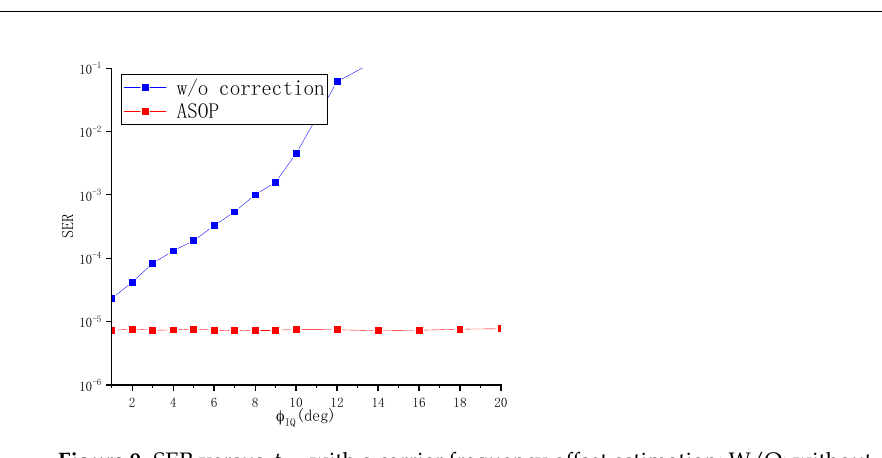
( c )( b ) 5 O 10 O 15 O GSOP w/o correction Ideal GSOP SER OSNR/0.1nm (dB) ( a ) 5 O 10 O 15 O SYOP w/o correction SER OSNR/0.1nm (dB) 5 O 10 O 15 O ASOP w/o correction SER OSNR/0.1nm (dB) Figure 8. Symbol error rate (SER) versus the optical signal-to-noise ratio (OSNR) with different ϕ IQ of 5°, 10°, and 15° for the ( a ) GSOP, ( b ) the SYOP, ( c ) and the ASOP; W/O: without. Figure 9 illustrates the SER performance as a function of ϕ IQ with a frequency offset of 400 MHz. The phase drift in the receiver caused by the frequency offset between the transmitter and the local oscillator could be compensated with the carrier frequency esti- mation algorithm. The carrier frequency estimation was completed by a frequency offset estimation module in VPI with the FFT-based frequency offset estimation algorithm. As we can see, without nonorthogonality compensation, the SER performance of 10 × 10 − 4 can